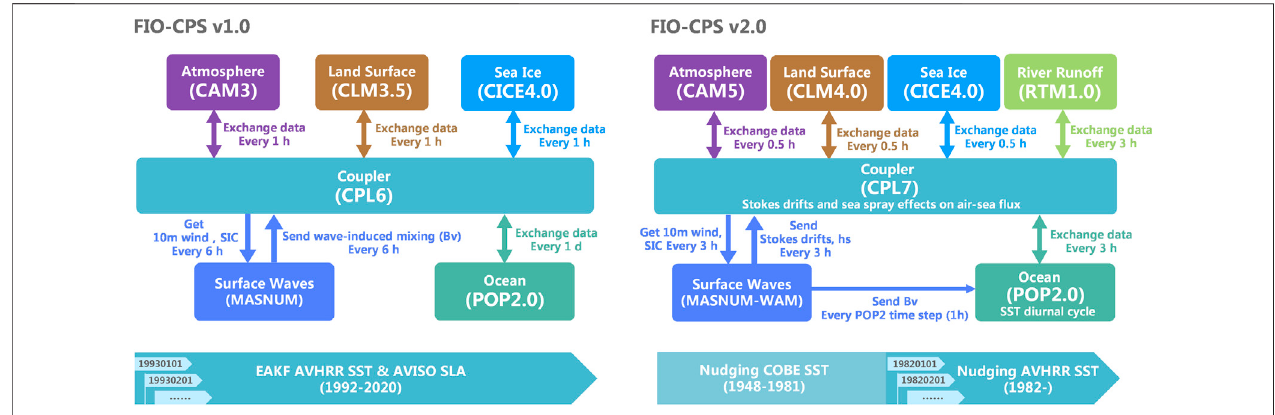
FIGURE 1 | Flowcharts for FIO-CPS v1.0 and FIO-CPS v2.0.